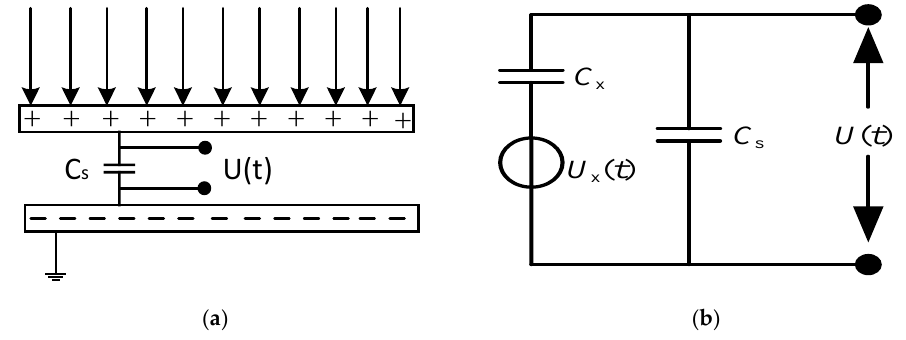
Figure 16. Electric field sensor: ( a ) Sensor schematic; ( b ) Equivalent circuit diagram.